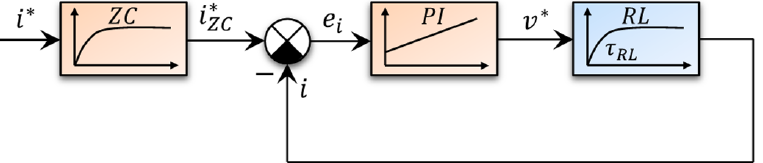
Figure 6. Block diagram of the simplified current loop scheme with zero ‐ cancellation.